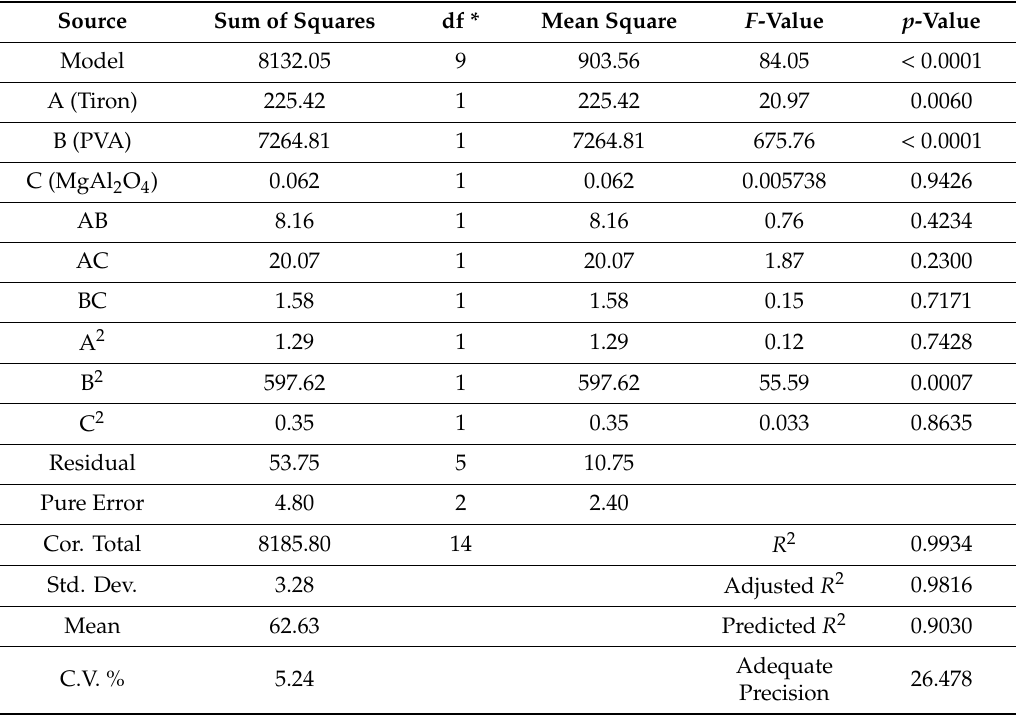
Table 2. ANOVA for response surface quadratic model for apparent viscosity of suspension. Source Sum of